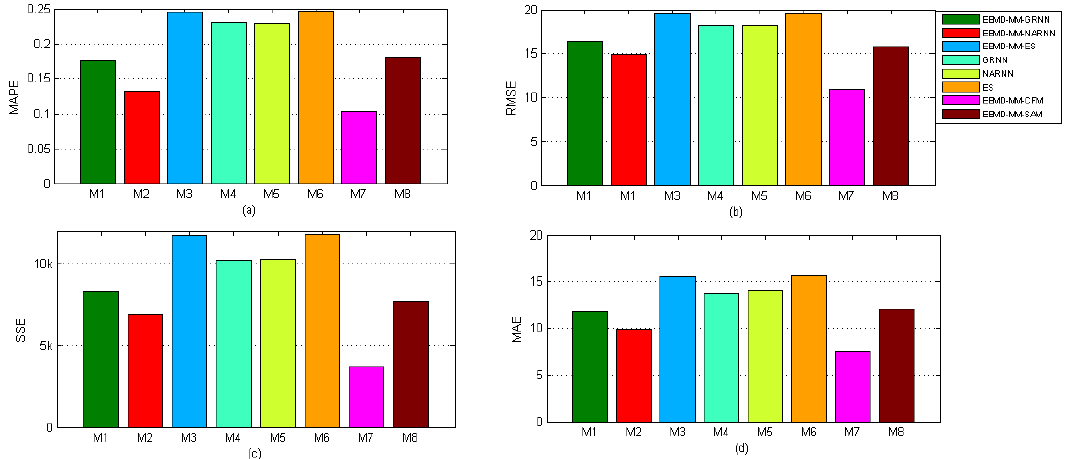
Figure 9. Performance comparison of different models in terms of different evaluation